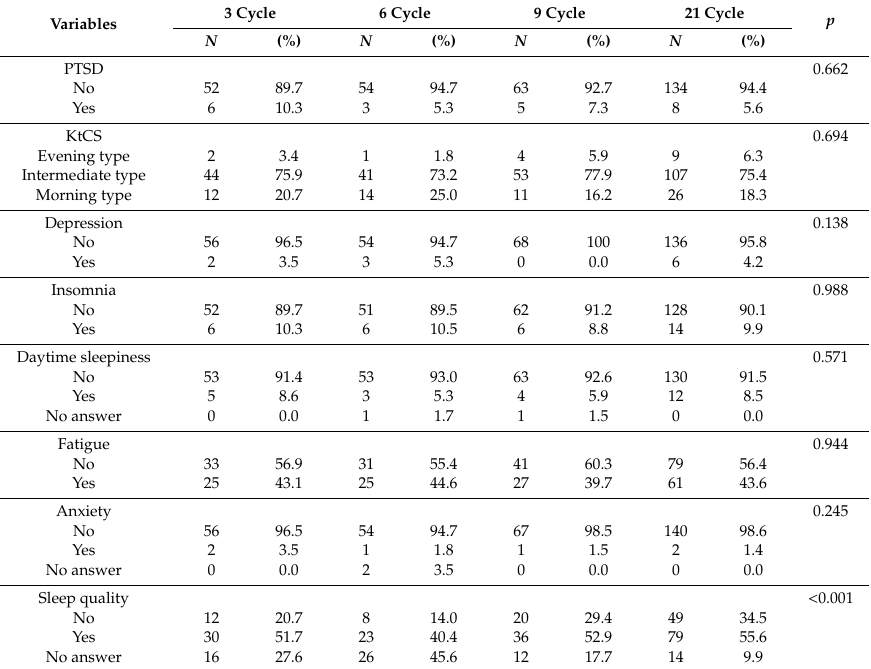
Table 2. Distribution of psychological health by shift cycle.